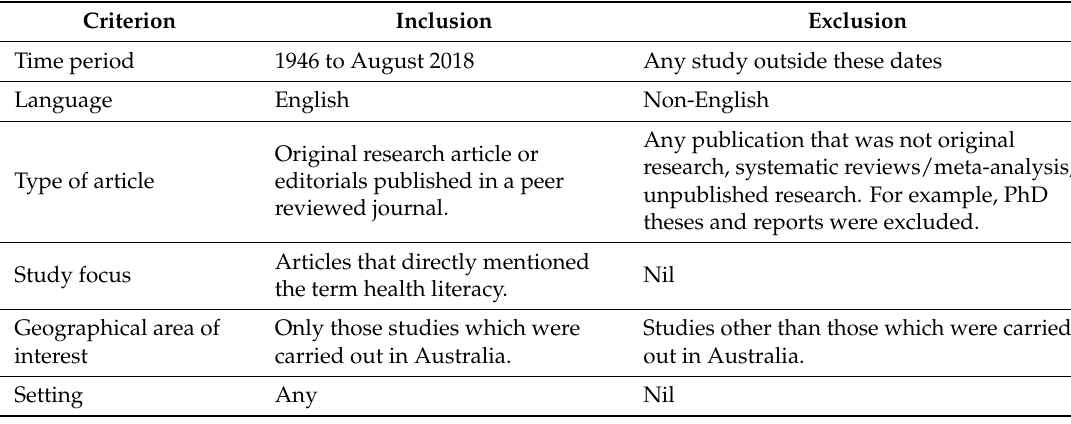
Table 2. Inclusion and exclusion